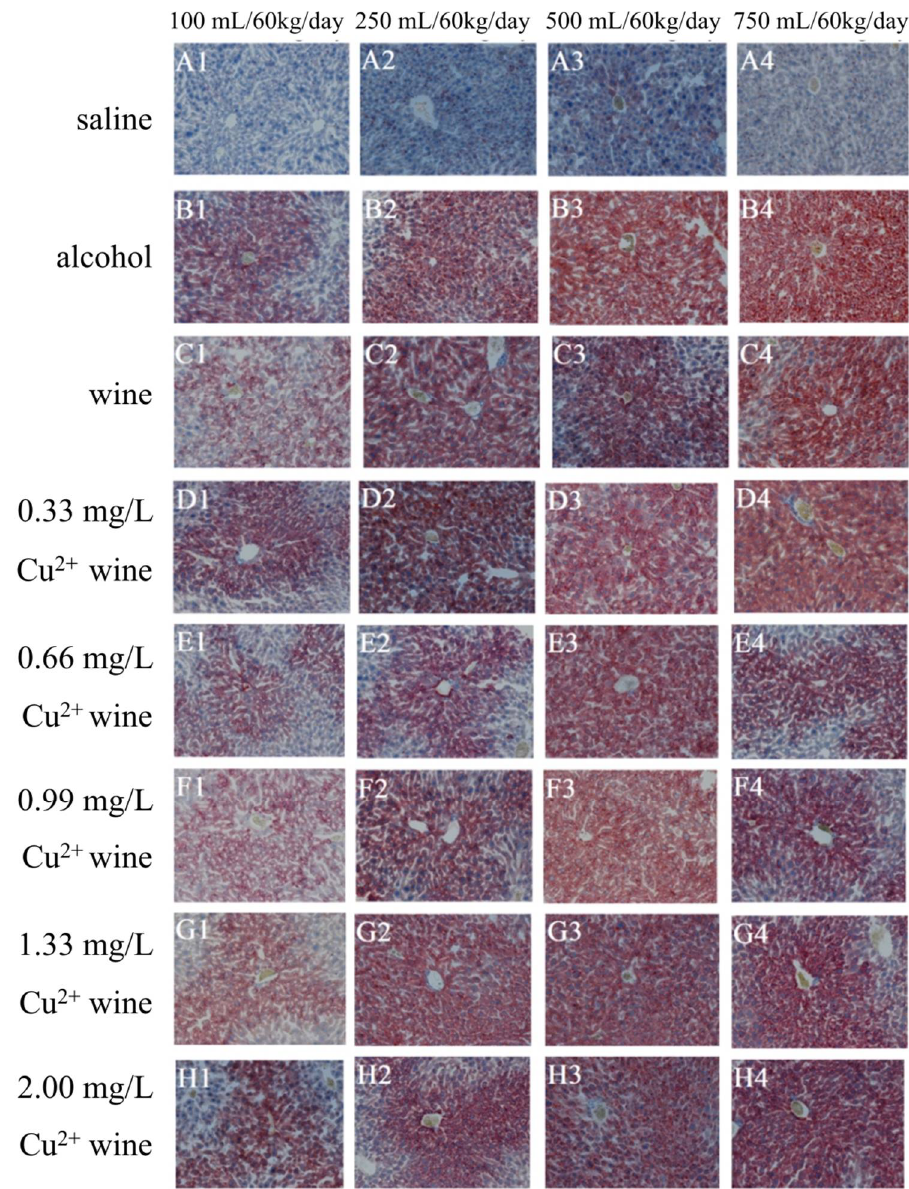
Figure 5. The oil red staining of mouse livers with 200 times magnification.